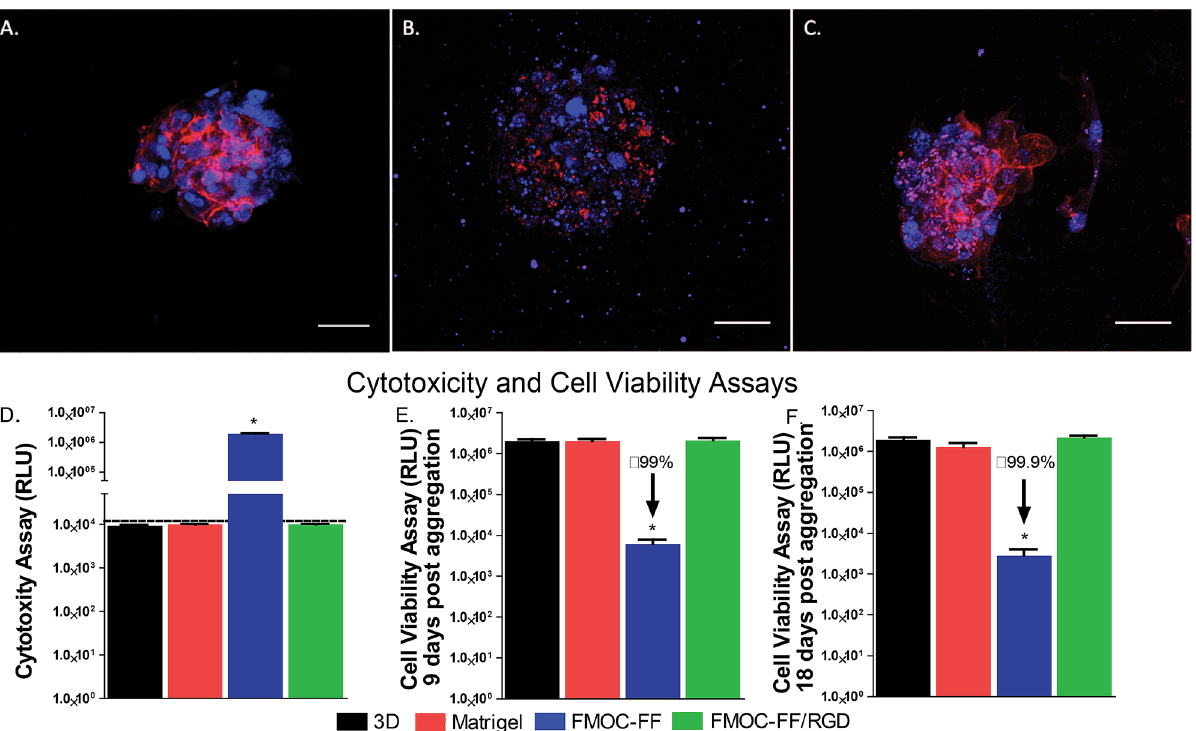
Figure 2. Actin-DAPI staining of primary hepatocyte aggregates cultured in Fmoc-FF/RGD ( A ) Fmoc-FF ( B ) and Matrigel ( C ) hydrogels (scale bars- 50 μm). PowerPoint Professional Plus 2013 and Graphpad Version 6.0 was used to make the